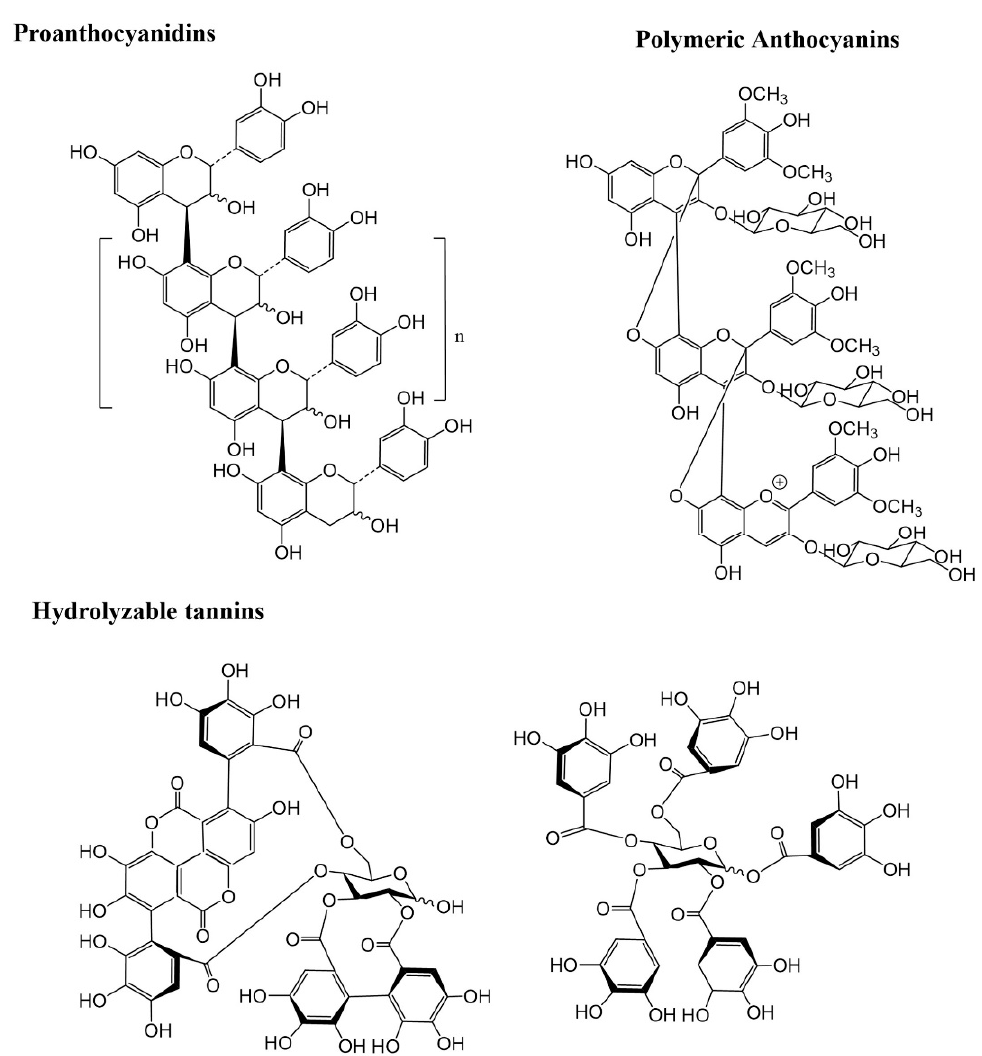
Figure 1. Chemical structure of the major nonflavonoids and flavonoids subclasses (aglycones).